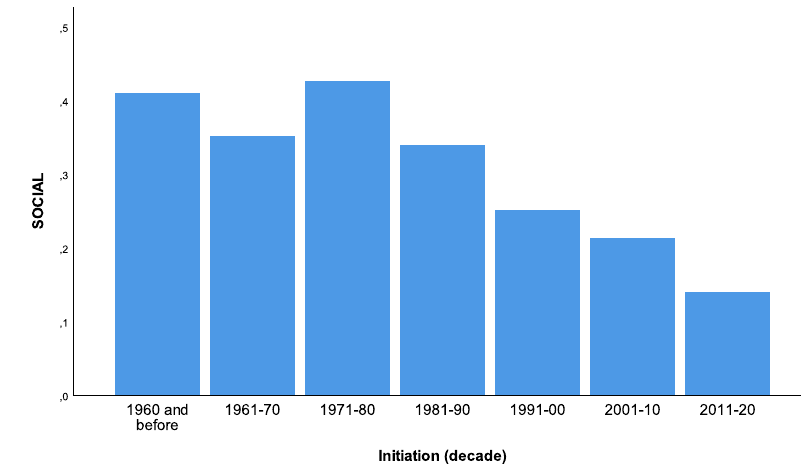
Fig. 5 Effects of decades on social initiation. Social factors as reason for initial involvement in relation to decade of